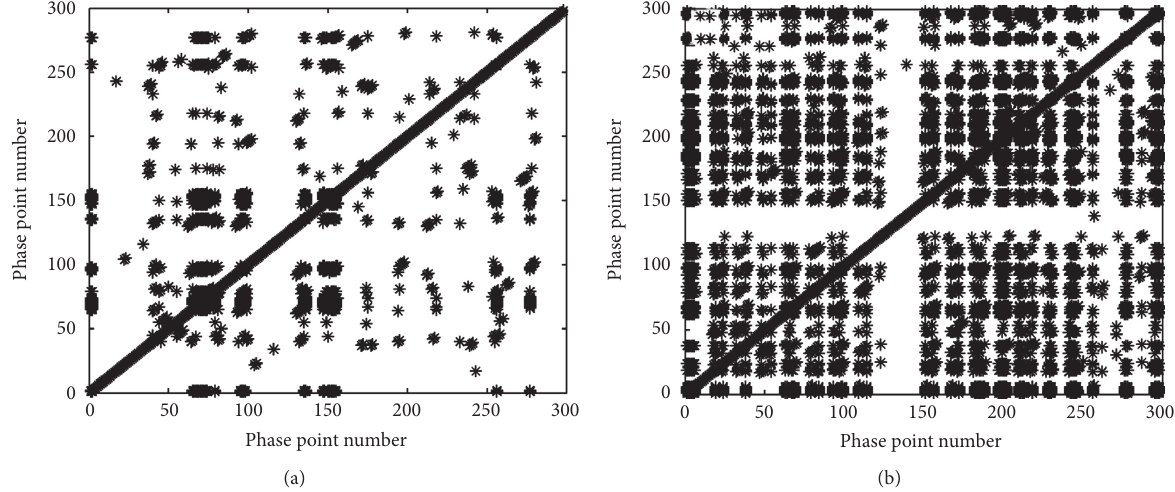
Figure 8: Recurrence plots of ore samples: (a) sample A; (b) sample